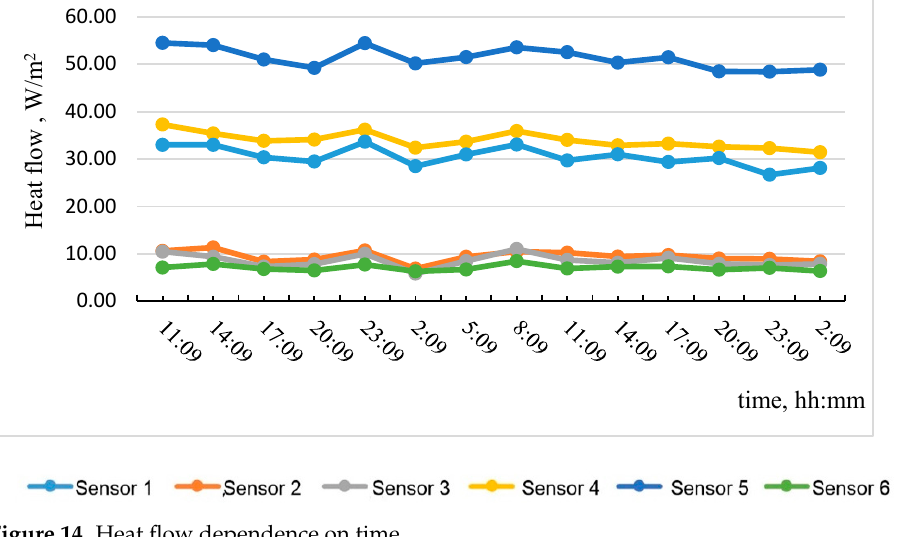
Figure 13. Temperature on the specimen No. 2 surface with time.